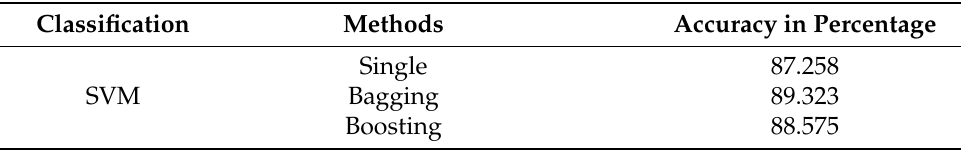
Table 3. Classification accuracies of single SVM and SVM ensembles.